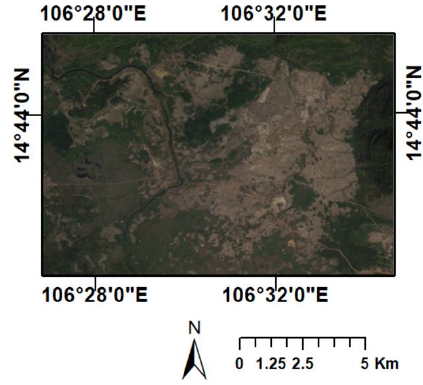
Figure 3. Landsat 8 image of the Hinlat area acquired on 16 01 2018, before the dam collapsed.